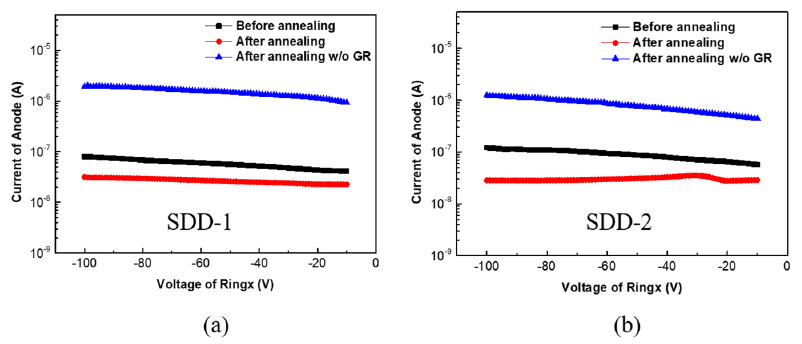
Figure 5. ( a , b ) The anode current of SDD-1 and SDD-2 at different test conditions (before annealing, after annealing and after annealing the ground ring not grounded), respectively.